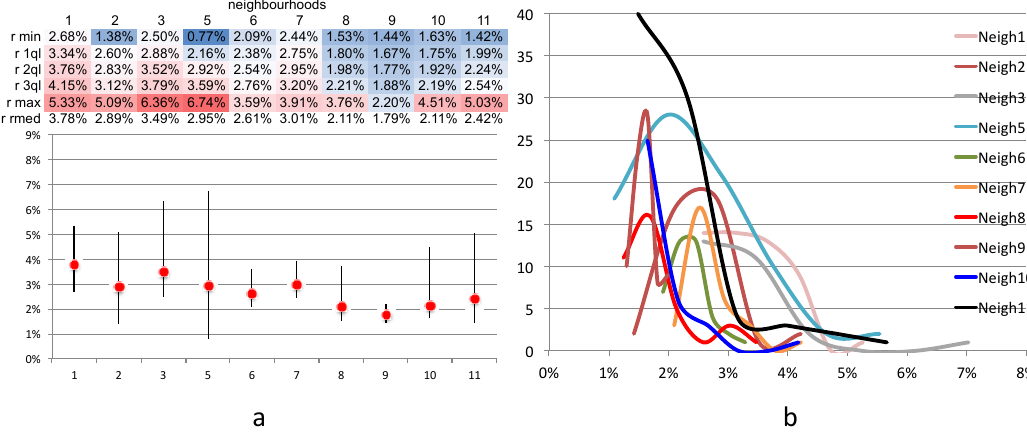
Figure 13. Cap rates in the neighbourhoods: ( a ) ranges and quartiles; ( b ) probability density functions.